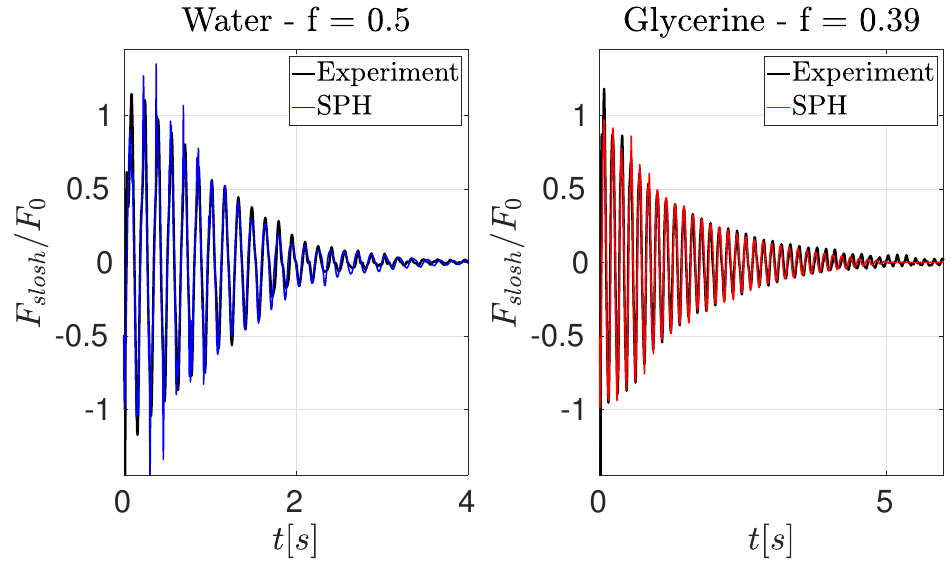
Figure 9. Comparison between δ -SPH simulations and experimental data of the nondimensional vertical sloshing force over time for water and glycerine decay tests at 10 g of maximum